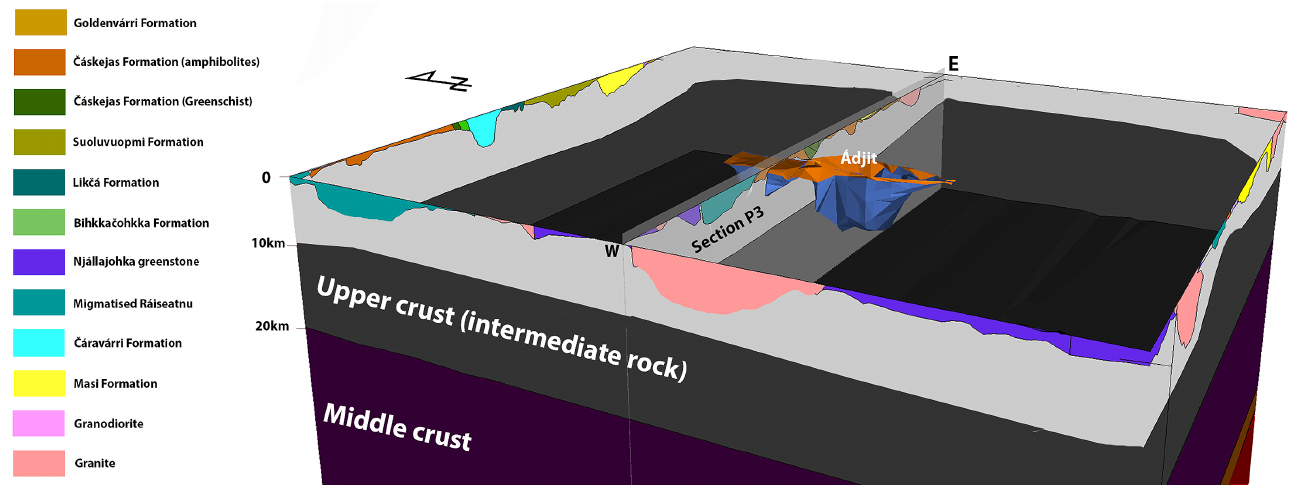
Figure 20. 3D density model of the Ádjit structure and its northern extension. The geological map is superimposed on the model, and section P3 is also shown (see Figure 14 for the vertical section